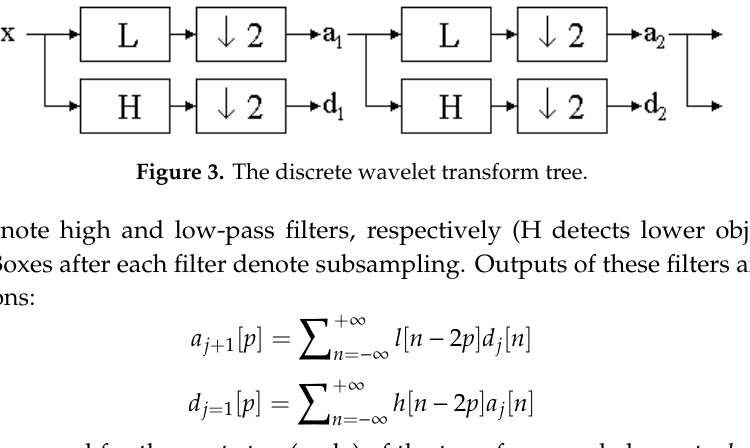
Figure 4. Wavelet decomposition for two-dimensional photography.